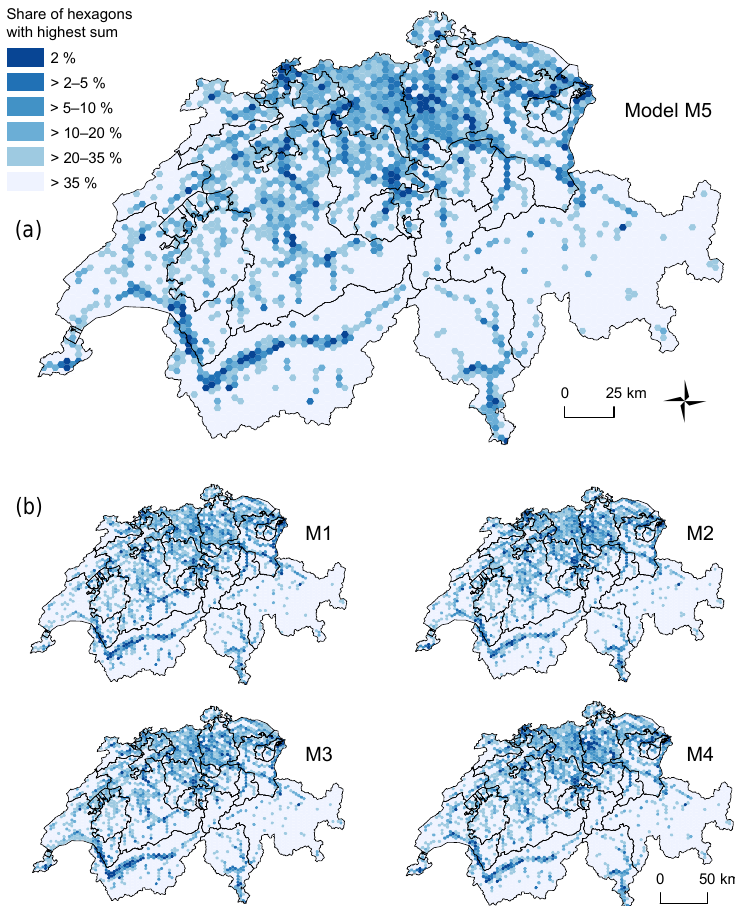
Figure 4. Spatial distribution of flood-exposed-building values based on benchmark model M5 (uppermost figure) in addition to models M1 to M4 (lower figures). Hexagons with a surface area of 10km 2 are categorized according to their sum of flood-exposed-building values. The specific limits of each category and the corresponding sums of exposed values are presented in Table 6. Map sources: Federal Office of Topography